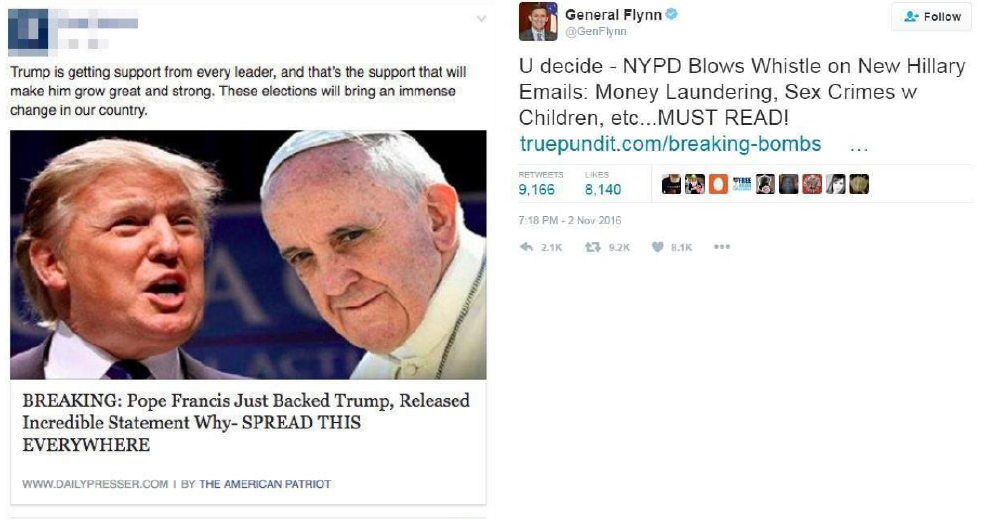
Figure 1. Examples of fake news